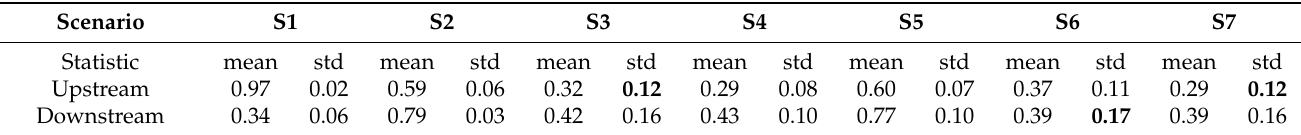
Table 5. Water level variation upstream and downstream of the river due to different sources of uncertainty (std: standard